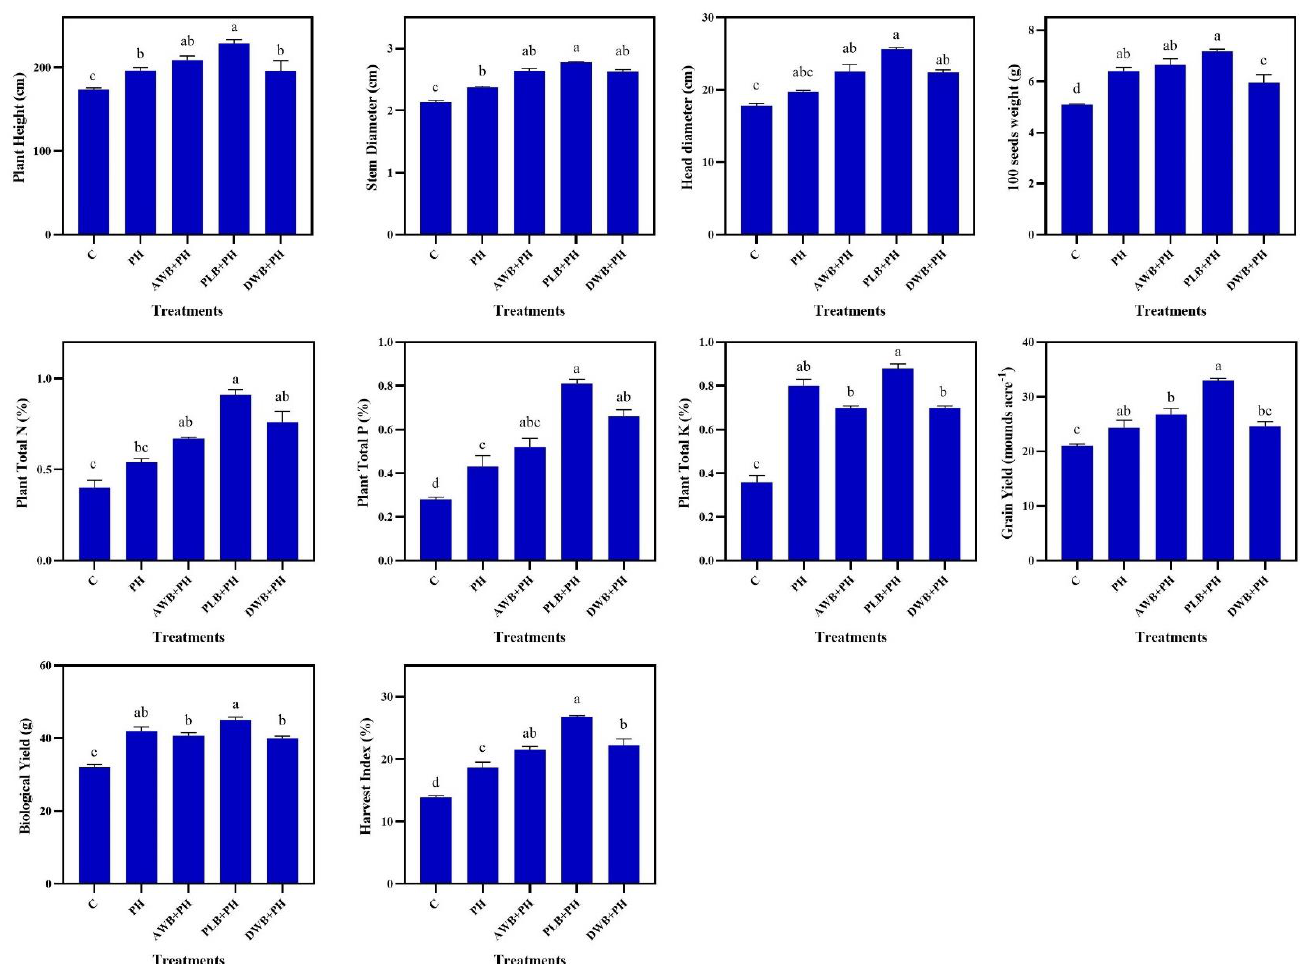
Figure 3. Effect of each treatment on plant nutrient stock and crop yield attributes under field conditions. Small letters on bars indicate significant differences among treatments at 5% probability levels, where significance was tested by using the multiple comparison LSD test. Error bars show the standard error of the mean (n = 3). Treatment abbreviations can be found in Table 1.